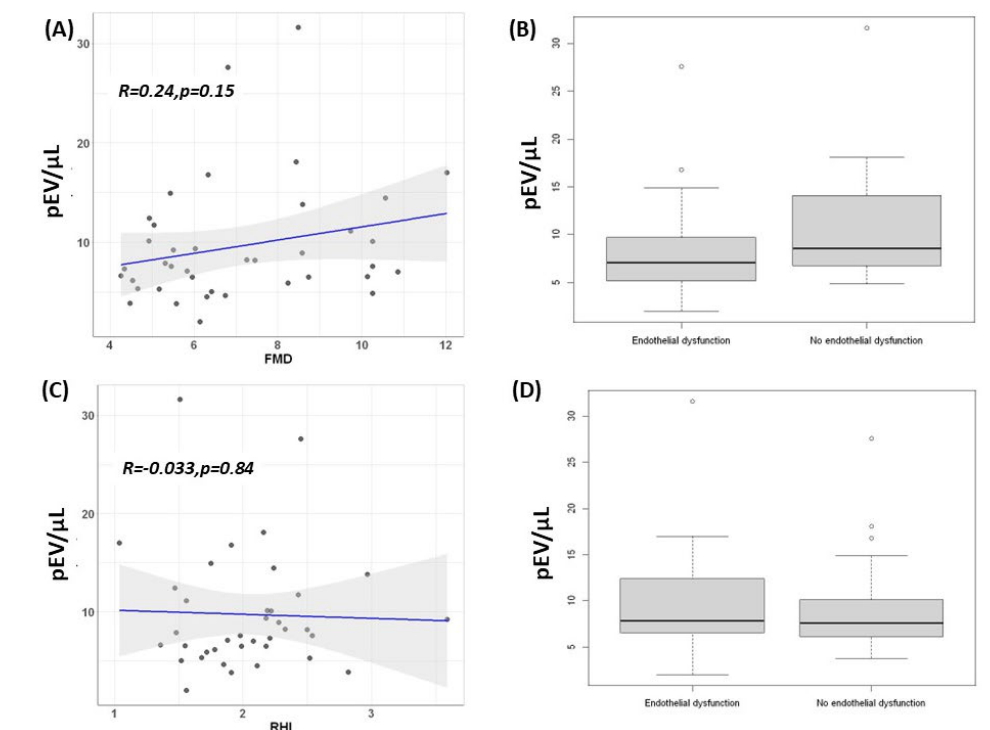
Figure 3. Platelet derived extracellular vesicles and endothelial function. ( A ) Scatterplot of extra- cellular vesicles and flow mediated dilatation ( p = 0.15). ( B ) Boxplot of extracellular vesicles and patients with and without endothelial dysfunction according to the FMD measurements ( p = 0.19). ( C ) Scatterplot of the extracellular vesicles and reactive hyperaemia index ( p = 0.84). ( D ) Boxplot of the extracellular vesicles and patients with and without endothelial dysfunction according to the reactive hyperaemia index measurements ( p = 0.57). Blue line represents the regression line of best fit. The grey bands around the line represents 95% confidence intervals.